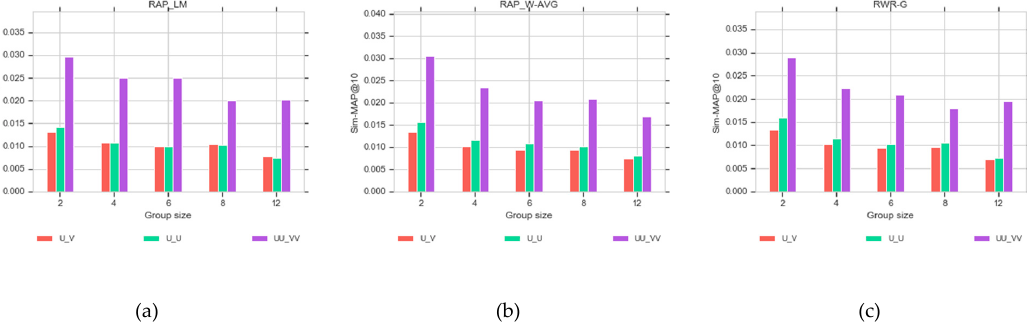
Figure 10. Sim-MAP values of the RWR algorithm at top-10 recommendations (vertical axis) in di ff erent group recommendation strategies, including: ( a ) RAP_LM, ( b ) RAP_W-AVG, and ( c ) RWR-G at di ff erent group sizes (horizontal axis) and three graph models of U-V, U-U, and UU-VV graphs.